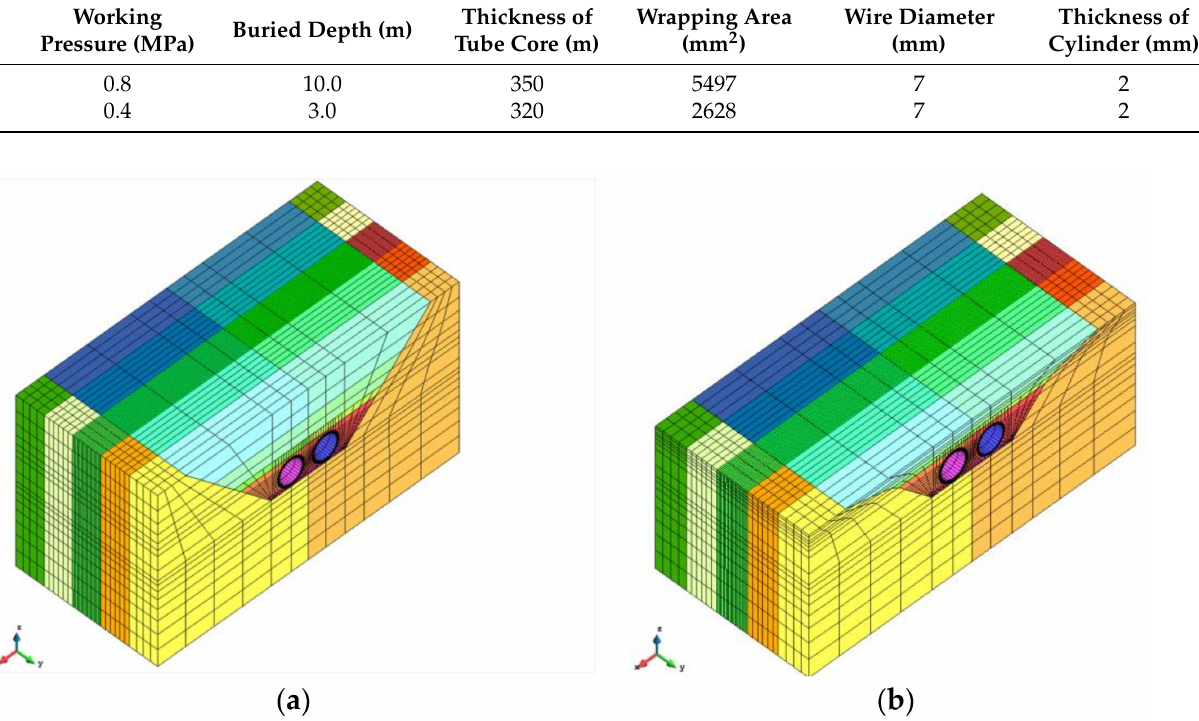
Figure 6. FEM model of pipe: ( a ) pipe No.1, ( b ) pipe No.2.